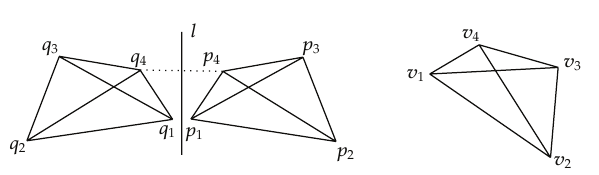
Figure 1: Congruent complete graphs and corresponding point sets.